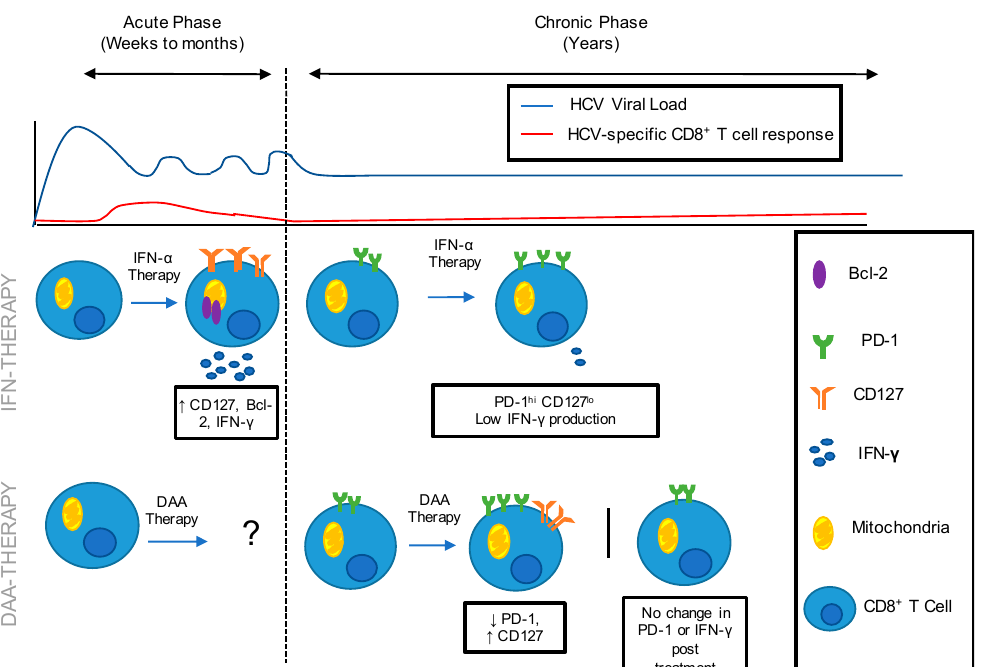
Figure 1. HCV-specific Immune Restoration following IFN and DAA therapy administered during the acute and chronic phase of HCV infection. HCV is characterized by an acute phase of infection in which the immune response is unable to control HCV replication, leading to chronicity in the majority of patients. Following IFN- α therapy administered during acute HCV infection: CD8 + T cell populations expressed low levels of exhaustion marker, PD-1 and increased levels of memory marker CD127, anti-apoptotic marker Bcl-2 and IFN- γ production. Following IFN- α therapy administered during chronic HCV infection: CD8 + T cell populations expressed high level PD-1 and low level of CD127 and IFN- γ production. Immune restoration following DAA therapy administered during acute HCV infection has not been documented in the literature. Following DAA therapy administered during chronic HCV infection: Literature demonstrates varying results. Decreased PD-1 and increased CD127 has been reported, while no change in PD-1 expression post-treatment has also been reported.